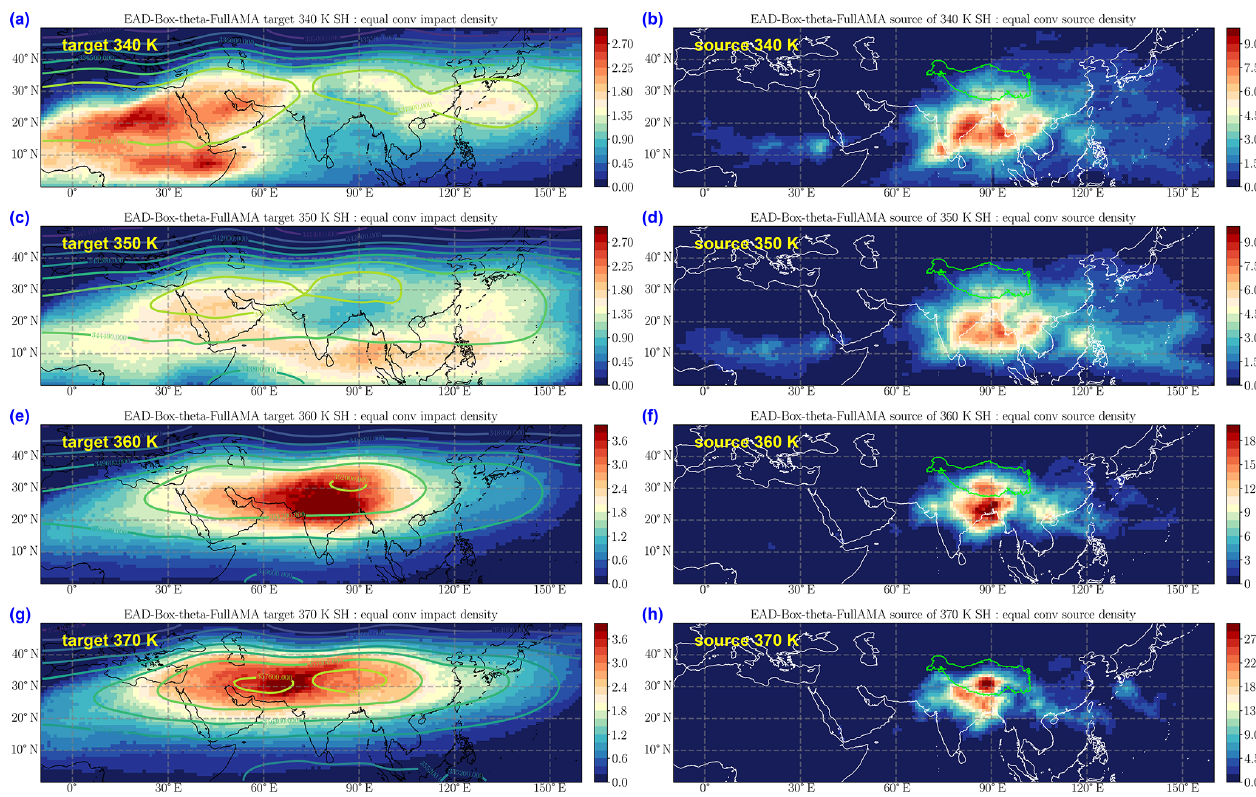
Figure 7. Left column (a, c, e, g) : equalized impact density on isentropic levels (from top to bottom) (a) 340K, (c) 350K, (e) 360K and (g) 370K for ERA5 diabatic trajectories (EAD). Contours: Montgomery potential at the same levels. Right column (b, d, f, h) : equalized source density for the same levels as in the left column and the same experiment. The green contour on the right panels (b, d, f, h) shows the Tibetan